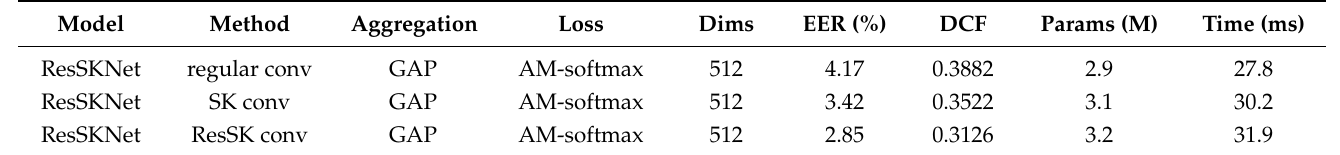
Table 2. Results of residual selective kernel convolution on Voxceleb1-O.